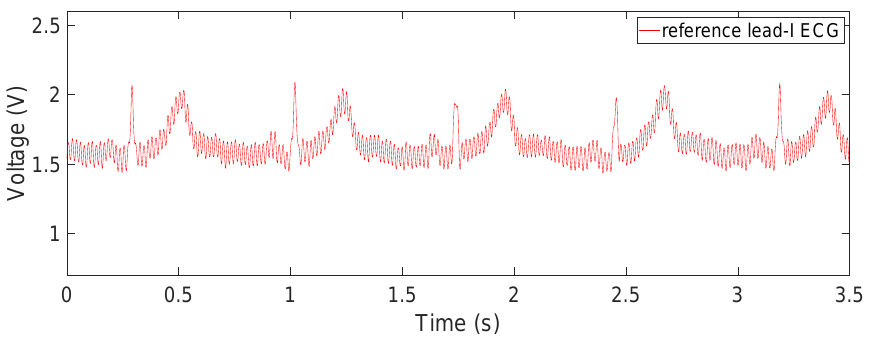
Figure 11. Reference Lead-I ECG signal measured by the commercially available ECG module (SparkFun